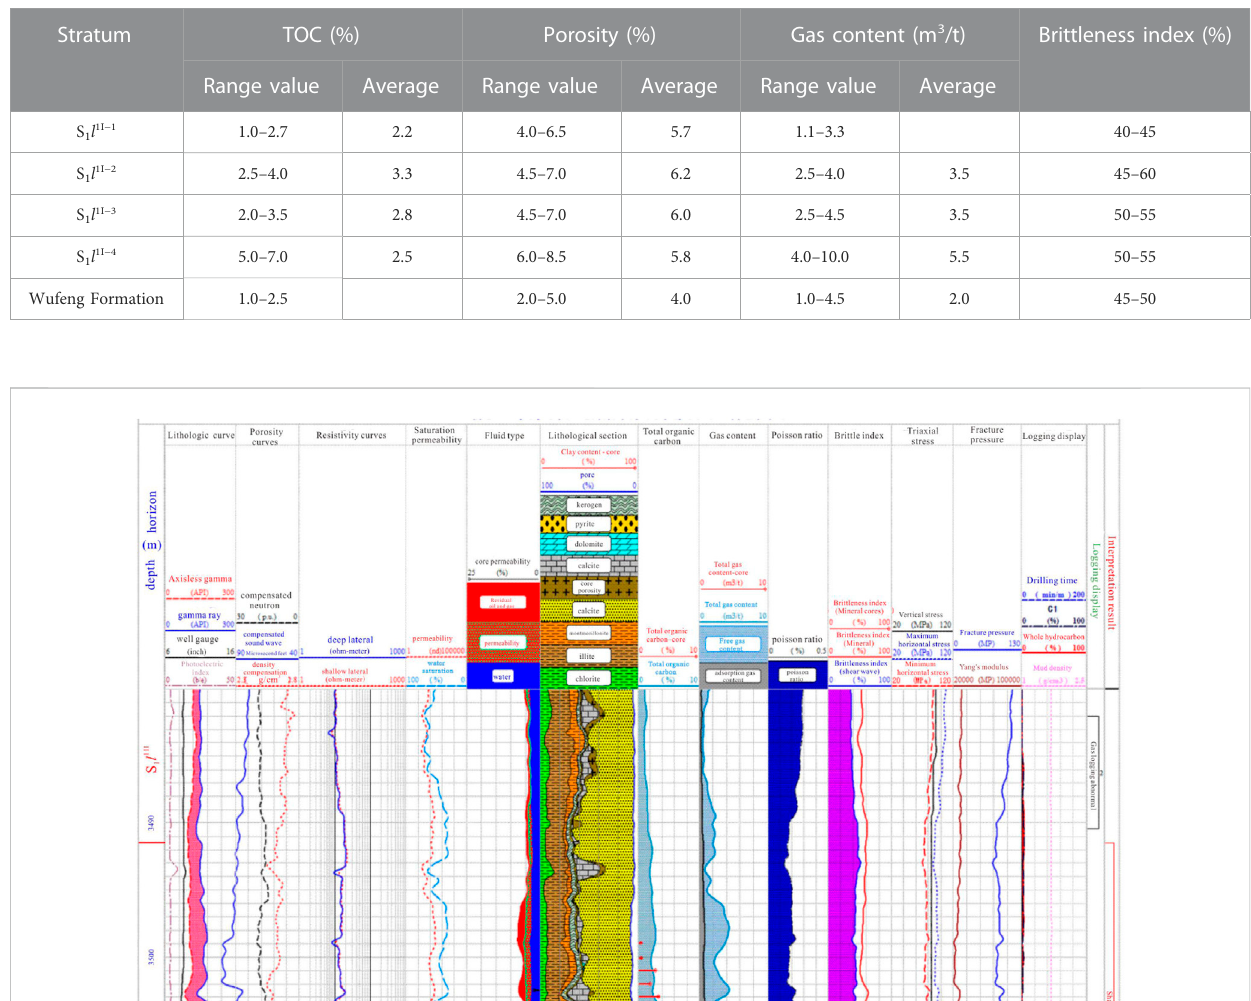
TABLE 2 Statistical table of logging response characteristics of well W204.